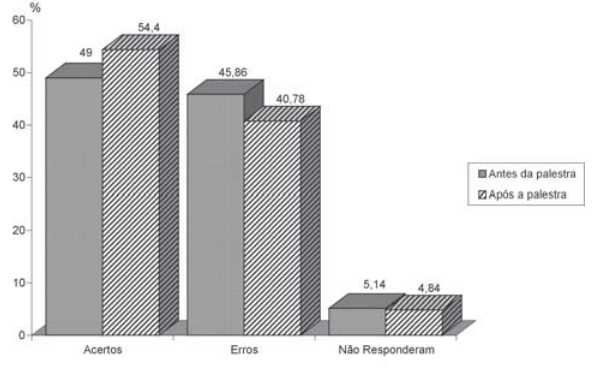
FIGURA 3 - Índice total de acertos e erros nos questionários preenchidos de acordo com abordagem das questões antes e após palestra